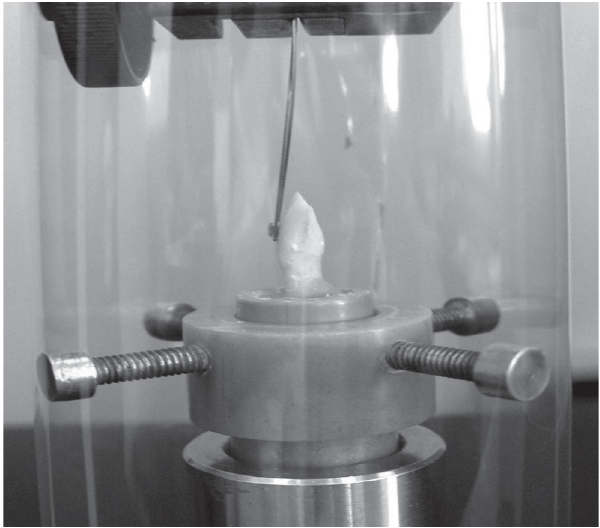
Fig. 1 . Shear strength testing in the Instron machine.